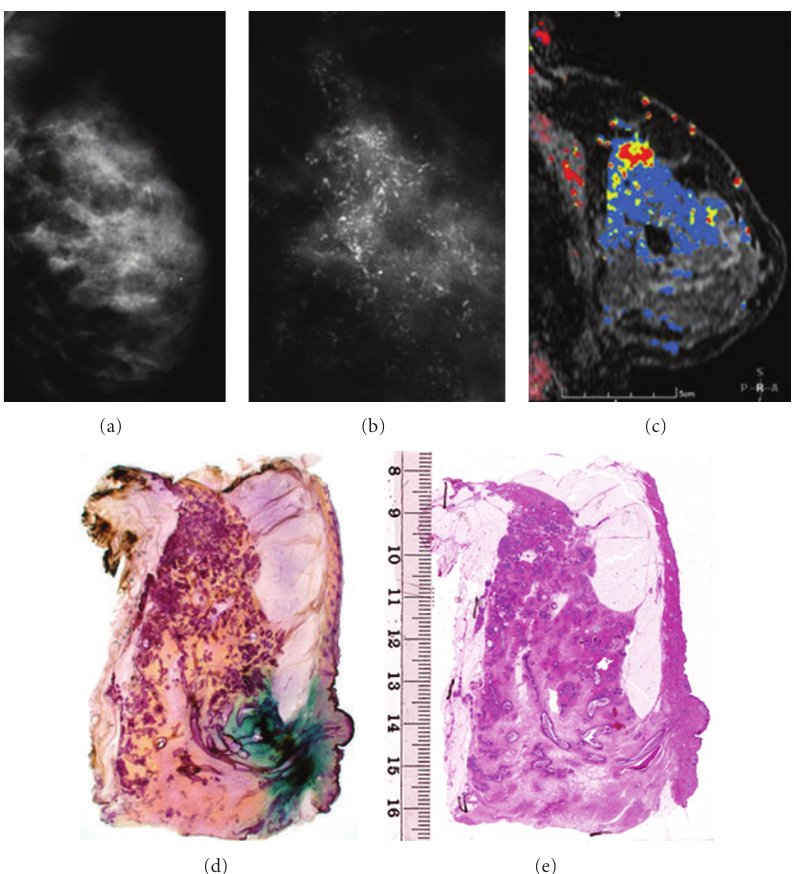
Figure 5: Left breast, mediolateral oblique projection (a) and microfocus magnification (b). Casting type calcifications are seen in the entire upper portion of the left breast, indicating an extensive malignant process within the ducts. The breast MRI examination (c) confirms the extensive nature of the disease and detects an invasive focus in the axillary tail. Large thick section (subgross, 3D) (d) and large thin section (e) histology provide excellent correlation with the imaging findings by demonstrating a 12 × 12 mm invasive breast cancer and a large number of cancer-filled, distended, duct-like structures occupying the entire upper portion of the left